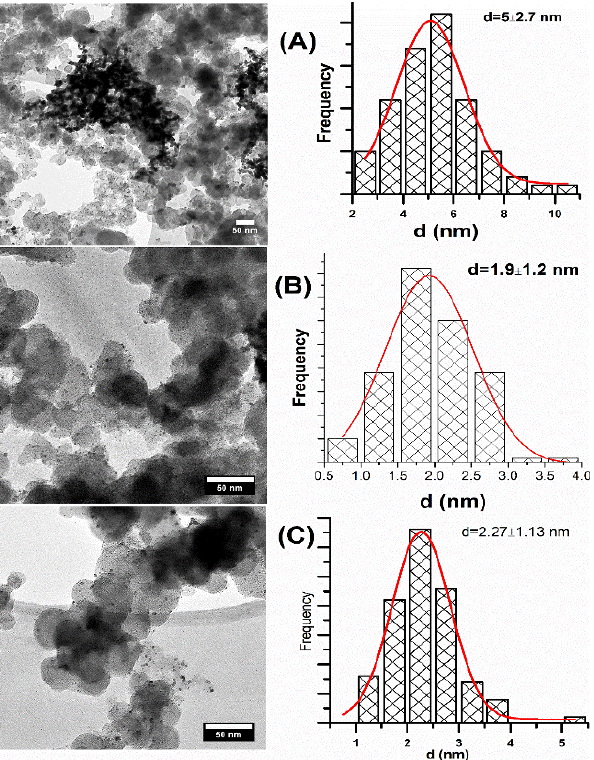
Figure 4. TEM micrographs and particle size distribution of Pd/C ( A ), PdIrNi/C ( B ), Pd 4 Ir 2 Ni 1 /C ( C ).